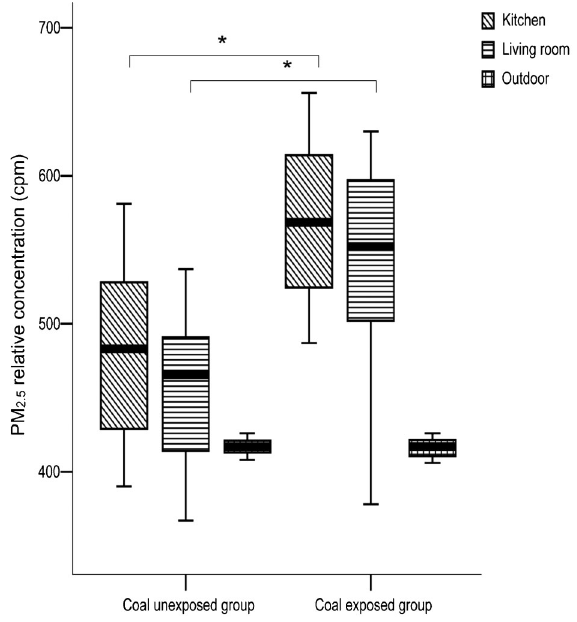
Figure 2. PM 2.5 relative concentration according to coal exposed and unexposed groups. *P , 0.05, t